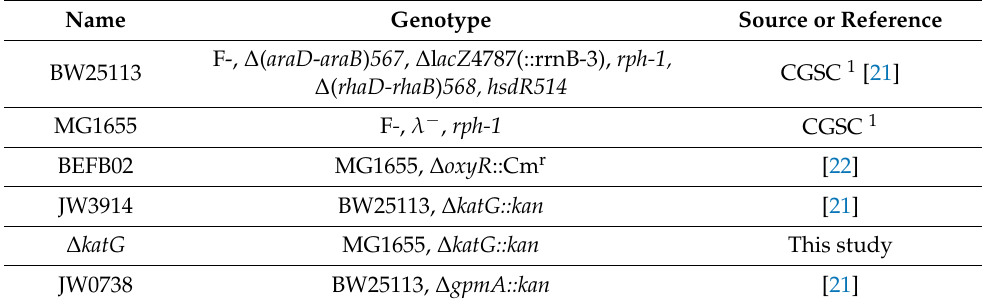
Table 1. Bacterial strains and plasmid used in this